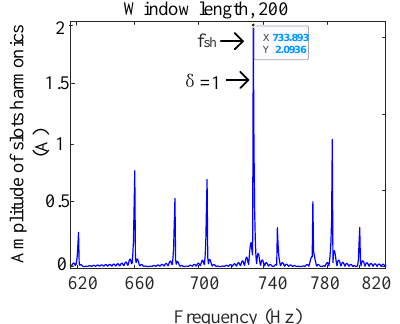
Figure 5. ( a ) Voltage waveform, ( b ) current waveform.